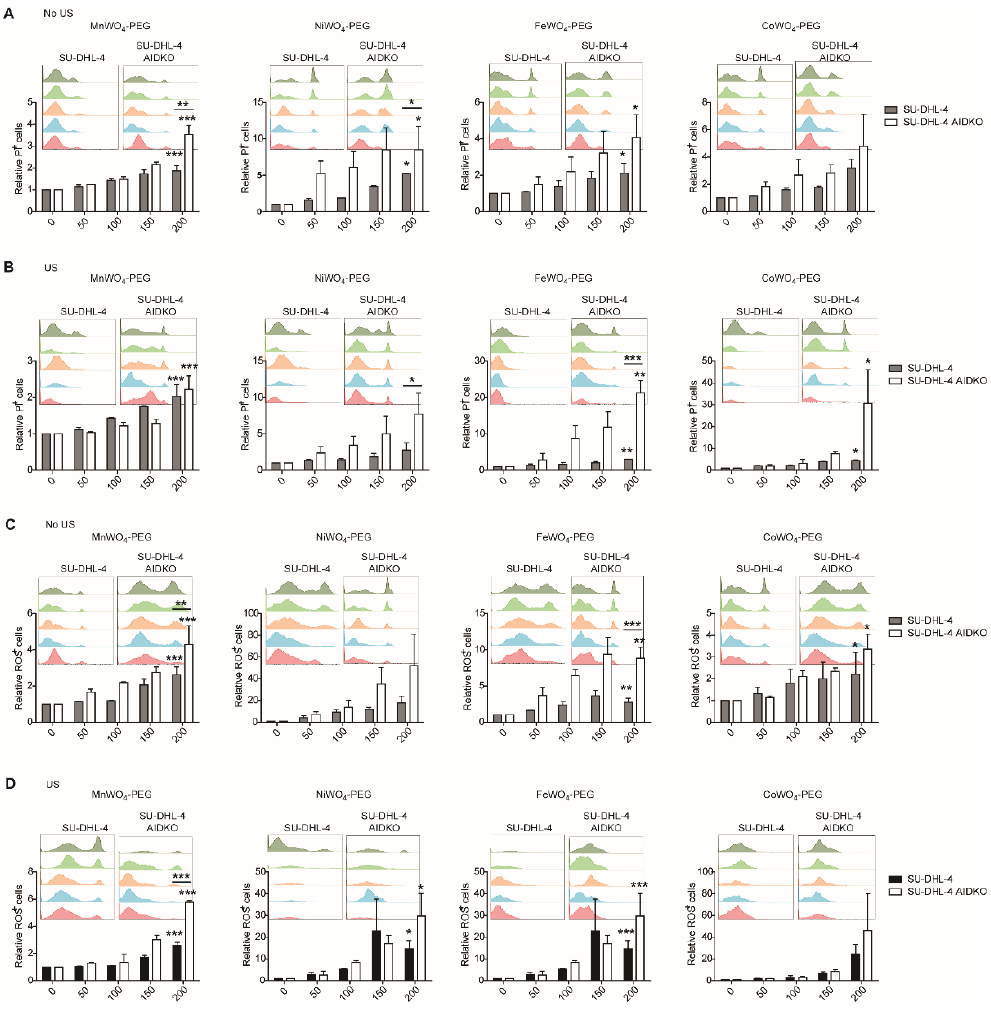
Figure 5. Cytotoxicity to DLBCL caused by MWO 4 -PEG NPs combined with AID deficiency. ( A ) The relative PI + generation of human SU-DHL-4 and AIDKO SU-DHL-4 cells was treated by increasing concentration (0, 50, 100, 150, 200 μ g/mL) of four MWO 4 -PEG NPs without US irradiation. The PI was used to stain the NPs treated DLBCL cells to indicate apoptosis cells. The percentage of PI + cells after the administration of MnWO 4 -PEG NPs without US activation was detected by flow cytometry. ( B ) The apoptosis rate of human SU-DHL-4 and AIDKO SU-DHL-4 cells was treated by increasing concentration (0, 50, 100, 150, 200 μ g/mL) of four MWO 4 -PEG NPs with US irradiation. PI was used to stain the NPs treated DLBCL cells to indicate apoptosis cells. ( C ) The percentage of ROS generation by SU-DHL-4 and AIDKO SU-DHL-4 cells after incubation with different concentrations (0, 50, 100, 150, 200 µ g/mL) of MWO 4 -PEG NPs in the absence of US. ( D ) The percentage of ROS generation by SU-DHL-4 and AIDKO SU-DHL-4 cells after incubation with different concentrations (0, 50, 100, 150, 200 µ g/mL) of MWO 4 -PEG NPs in the presence of US. The upper showed the primary data obtained from flow cytometry. The lower showed the statistical chart of relative PI + or ROS + cells. The data shown are representative of 3 independent experiments. Data are represented as mean ± SD. *, ** and *** represent p < 0.05, p < 0.01 and p < 0.001, respectively. The AID levels in DLBCL cells with the administration of four NPs (200 µ g/mL) were detected to identify the inhibition of four NPs to AID. The immunoblotting showed cells (Figure 6A). The gray density of the immunoblotting bands was analyzed,